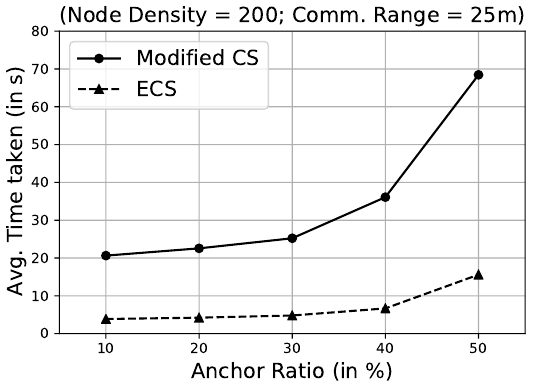
Figure 4. Comparison of modified Cuckoo Search (CS) algorithm and the proposed Enhanced Cuckoo Search (ECS) algorithm based on average time taken to localise one localisable